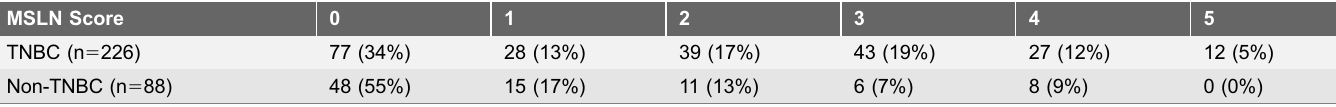
Table 2. Distribution of MSLN scores in TNBC versus non-TNBC.